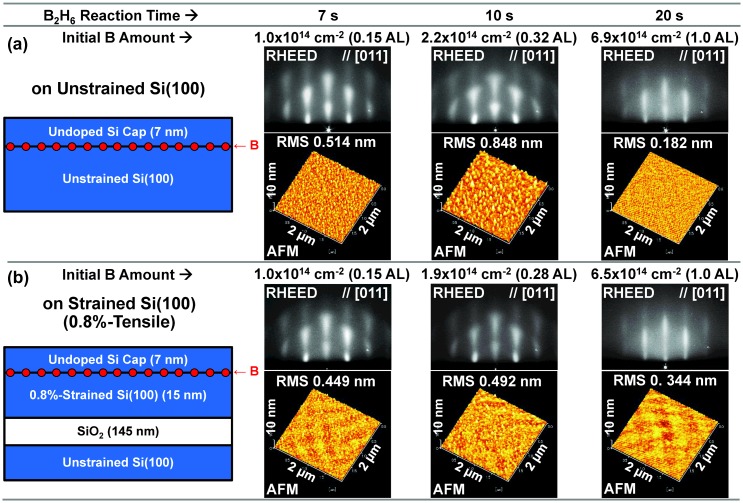
B2H6 reaction time dependence of initial B amount, RHEED patterns and AFM images for the B AL-doped Si films epitaxially grown on (a) the unstrained SOI and (b) the 0.8%-tensile-strained SOI. Root-mean-square (RMS) values of surface roughness are also shown in the AFM images. Si cap layer thickness was fixed at 7 nm.